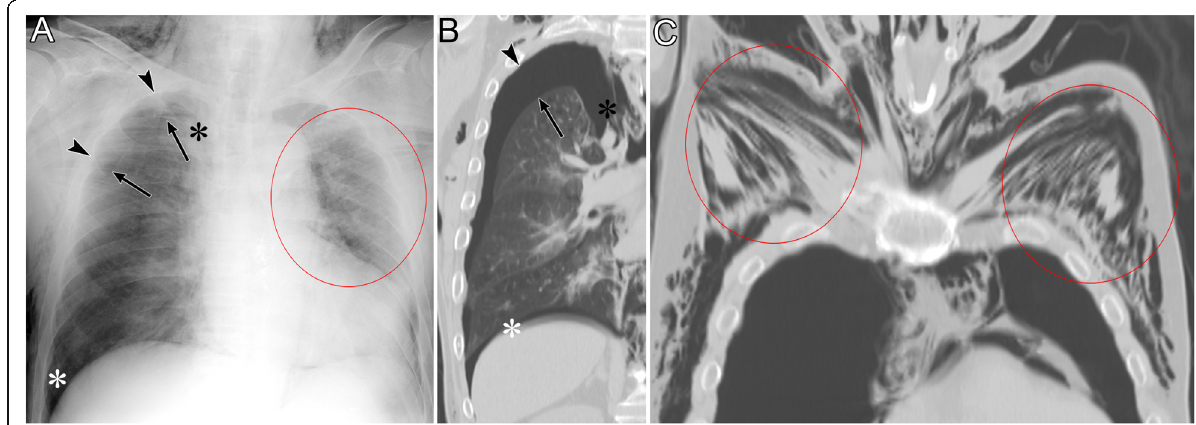
Fig. 5 Pneumothorax in the apicolateral space of a 77-year-old man. Esophageal perforation caused by endoscopic submucosal dissection for esophageal cancer resulted in pneumomediastinum, pneumothorax, and subcutaneous emphysema. a A supine radiograph shows the visceral pleural line (black arrows) in the apicolateral space. The black arrowheads indicate the parietal pleura. Pneumothorax in the anteromedial space (black asterisk) and subpulmonary space (white asterisk), pneumomediastinum, and subcutaneous emphysema (red oval) are also visible. No vascular markings exist beyond the visceral pleural line. Subcutaneous emphysema in the pectoralis major muscle shows a linear disposition that follows the direction of the muscle fibers. b A coronal CT image reveals the visceral pleural line (black arrow) and the lack of any structures in the pleural cavity. The parietal pleura (arrowhead), pneumothorax in the anteromedial space (black asterisk), and pneumothorax in the subpulmonary space (white asterisk) are also observed. c A coronal CT image shows a linear disposition of subcutaneous emphysema that follows the direction of the muscle fibers of the pectoralis major muscle (red